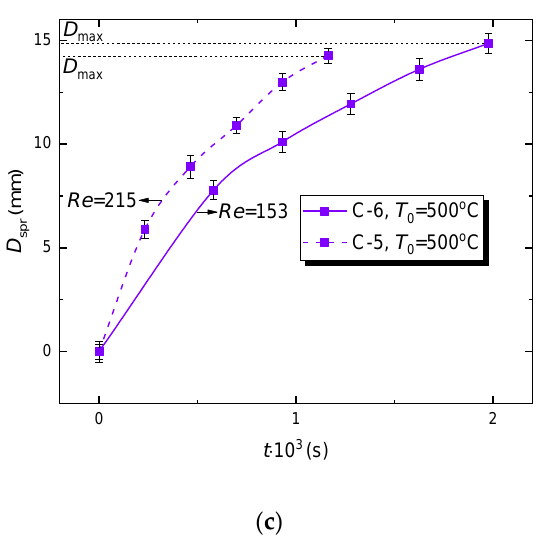
Figure 9. Variation of the spreading diameter of WiDME (C-6) and WiBDME (C-5) droplets versus time at different surface temperatures: ( a ) T 0 = 300 °C, ( b ) T 0 = 400 °C, ( c ) T 0 = 500 °C; slight difference in Re with other factors being equal is caused by minimum deviation of the average parent drop diameter.